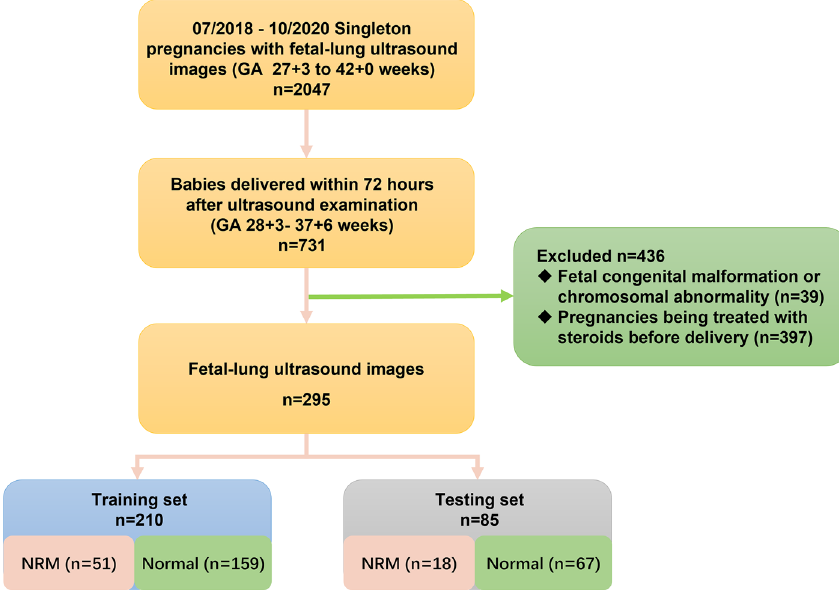
Figure 3. Flowchart of the selection of the study population. NRM neonatal respiratory